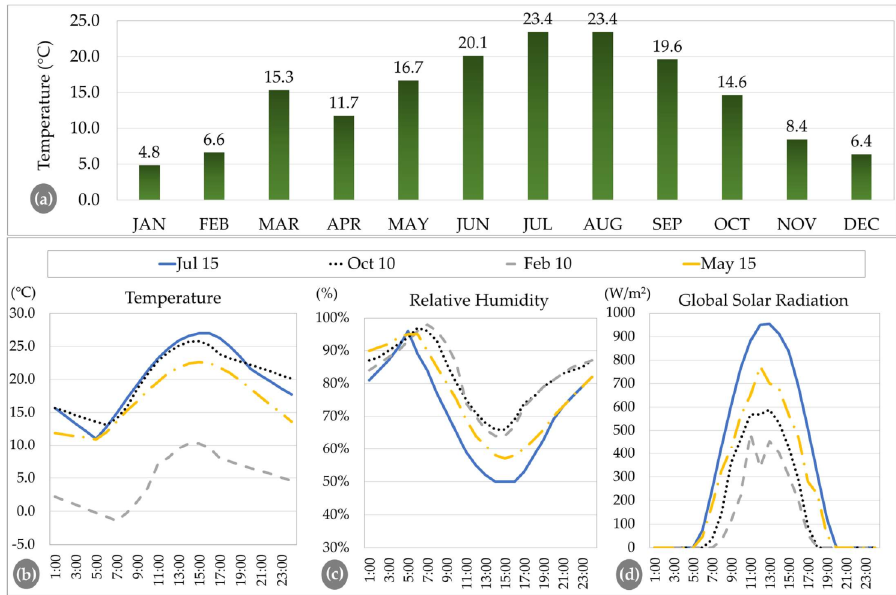
Figure 5. Average monthly outdoor air temperature ( a ); average hourly outdoor air temperature ( b ); relative humidity ( c ); and global solar radiation on horizontal surface ( d